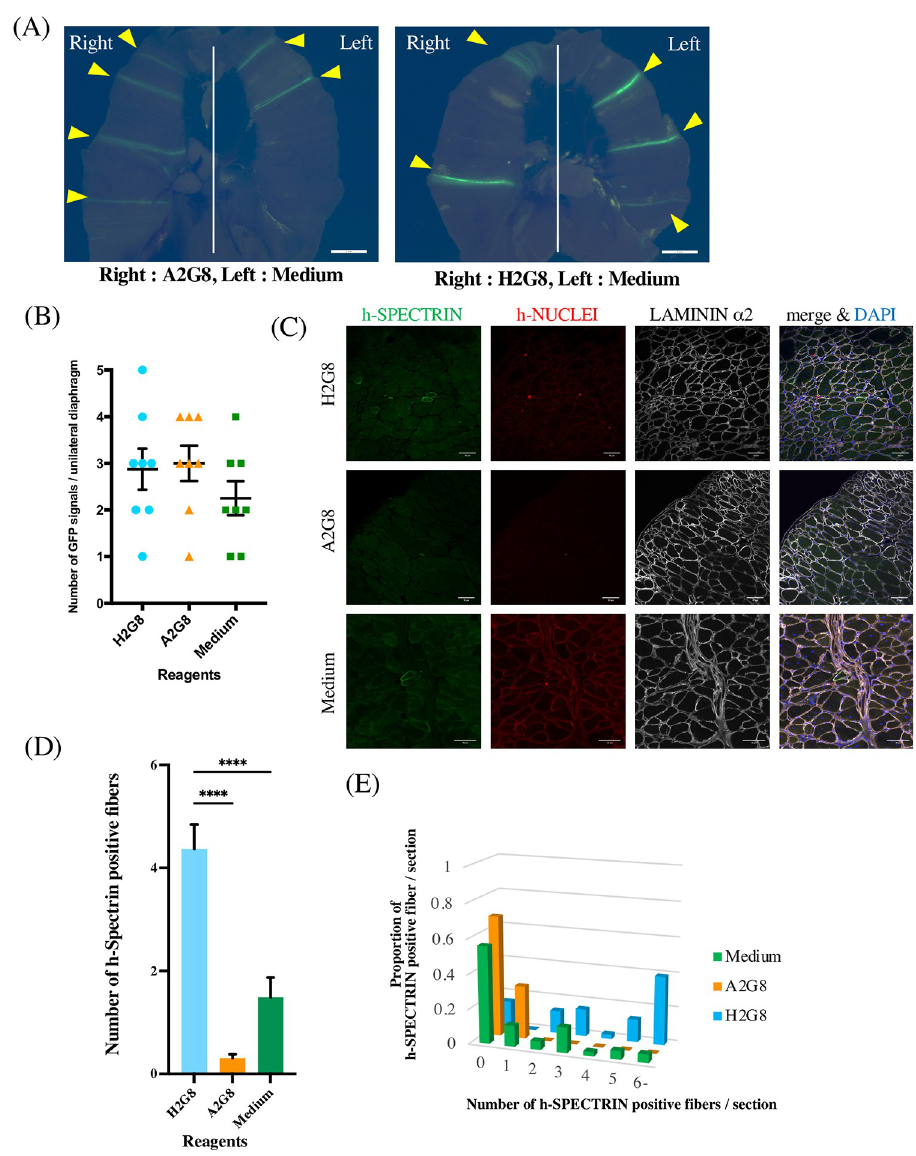
Fig 4. H2G8 reduces the frequency of iMuSC engraftment failure in the diaphragm of NOG-mdx mice. (A) A fluorescence stereomicroscopy image of the diaphragm 2 weeks after the transplantation of GFP-transgenic Hu5/KD3. Scale bars, 2 mm. Arrowheads show GFP. Data shown are from five independent experiments. Each of ten unilateral diaphragms were analyzed in the three groups (Medium, A2G8, H2G8). (B) Quantification of GFP signals in the unilateral diaphragm. Horizontal and vertical lines show means ± SEM (ANOVA with Tukey’s multiple comparison test). (C) Immunohistochemistry staining 4 weeks after the iMuSC transplantation. Sections were stained with anti-h- SPECTRIN antibody (green), anti-h-NUCLEI antibody (red), and anti-LAMININ α 2 antibody (white). Nuclei were stained with DAPI (blue). Scale bars, 50 μ m. (D) Quantification of h-SPECTRIN positive fibers 4 weeks after the iMuSC transplantation. Data show the mean ± SEM (ANOVA with Tukey’s multiple comparison test). ���� p < 0.0001. The number of sections is 38 (H2G8), 36 (A2G8) and 41 (Medium). (E) A histogram of h-SPECTRIN positive fibers per cryosection. The X-axis represents the number of h-SPECTRIN positive fibers in a single section, and the Y-axis represents the number of h-SPECTRIN positive fibers in a single section over all